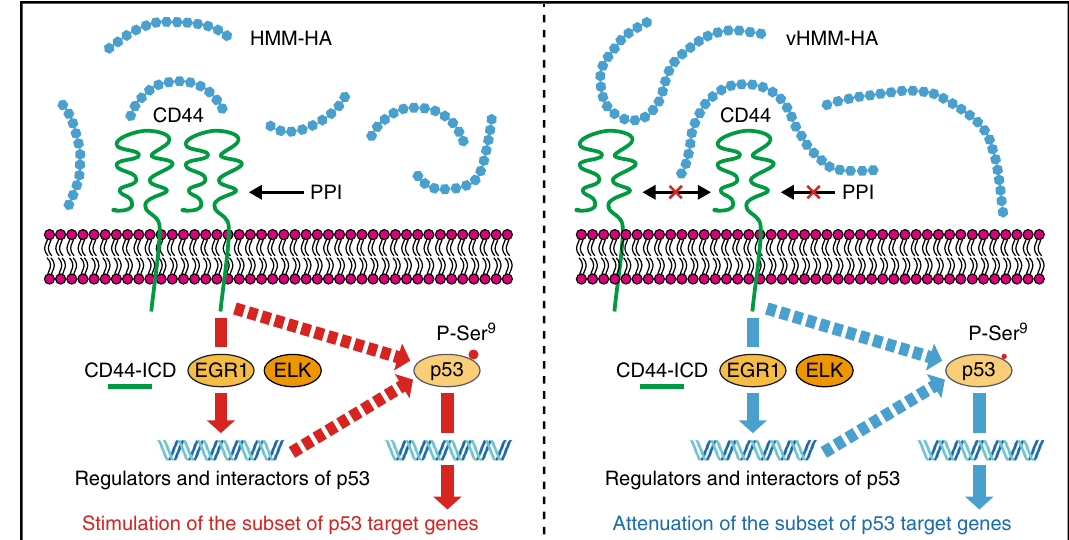
Fig. 5 Schematic model of the mechanism of protective effect of vHMM-HA. Our data indicate that vHMM-HA attenuates CD44 protein-protein interactions (PPI), whereas HMM-HA promotes them. Concomitantly, vHMM-HA suppresses CD44-dependent gene expression, including those regulated by CD44-dependent transcription factors such as ELK, EGR1, and CD44-ICD. vHMM-HA and HMM-HA thereby induce opposing effects on the expression of CD44-dependent genes, which are also associated with the p53 pathway. As a result, vHMM-HA partially attenuates p53 and its target genes, and protects cells in a p53-dependent